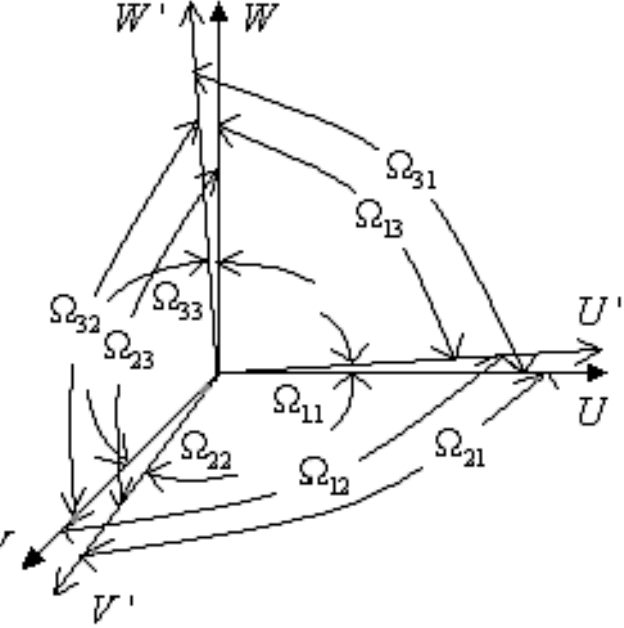
Figure 3. Three-dimensional (3D) rotational axes of the bed realignment method.